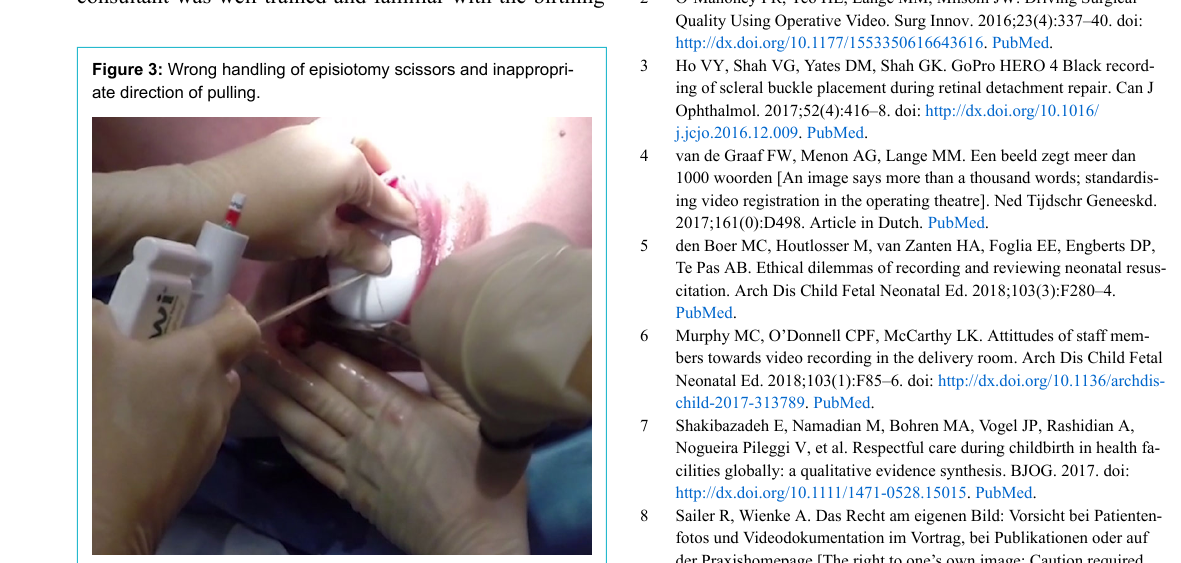
der Praxishomepage [The right to one’s own image: Caution